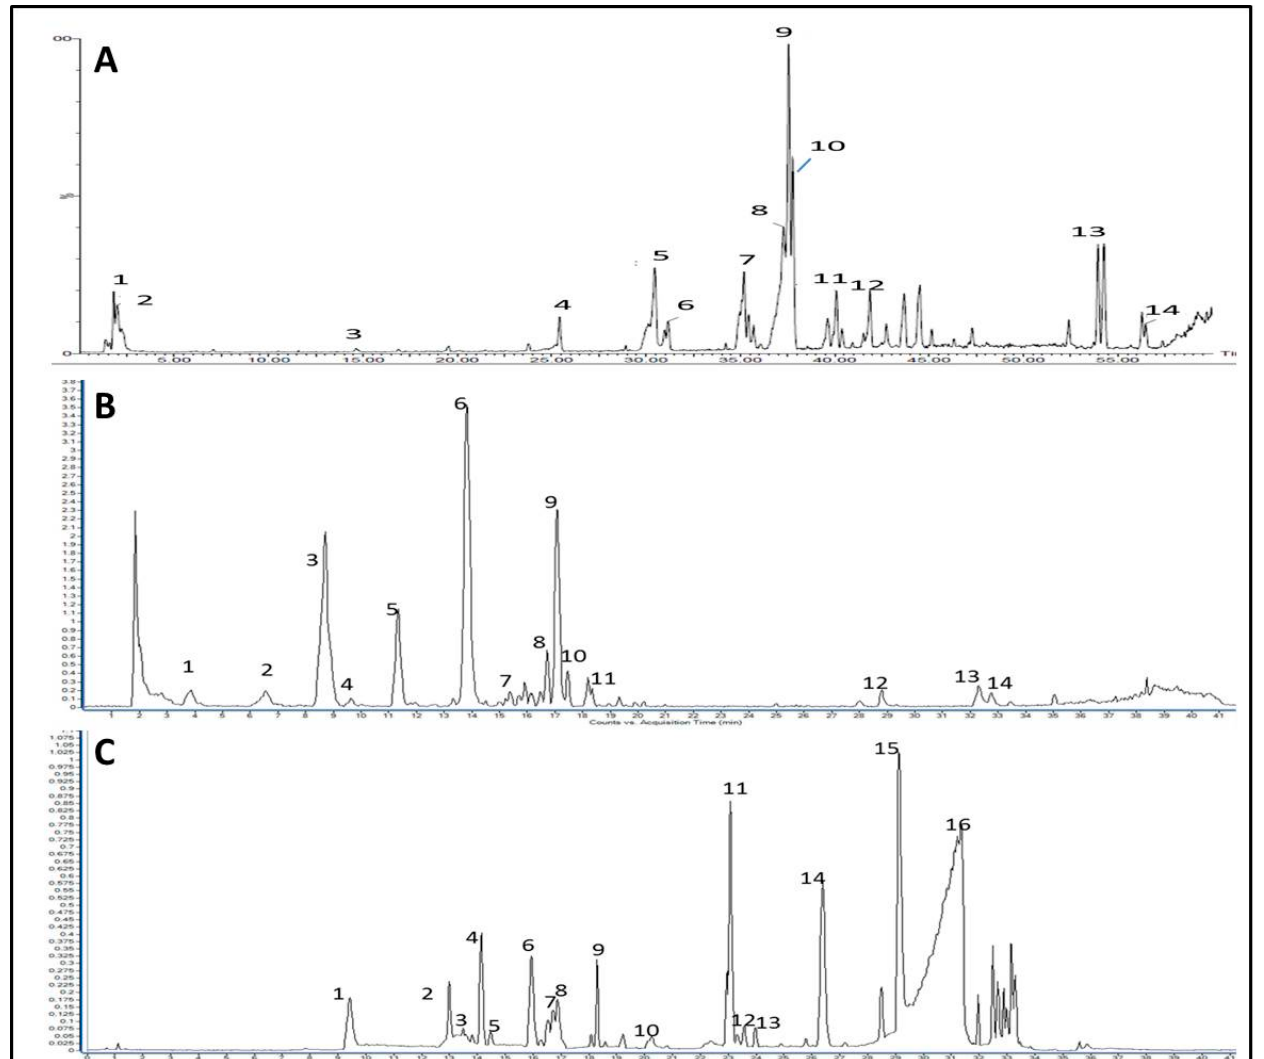
represented 64.8% of the total fatty acids and were represented by oleic acid (53.4%), trans oleic acid (6.2%), and palmitoleic acid (5.2%).